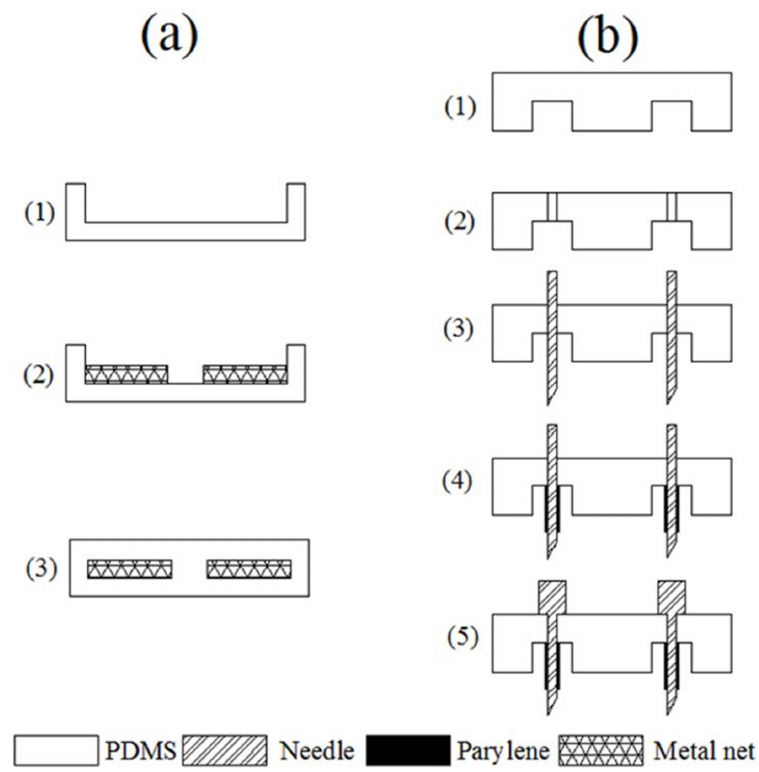
Figure 3. The fabrication process of device. ( a ) The fabrication process of the plug. ( b ) The fabrication process of